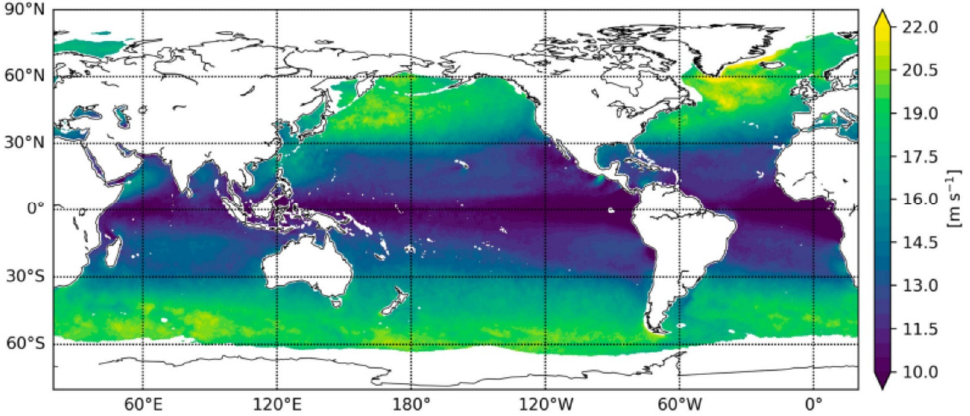
Figure 4. Ocean currents and research points. The red arrows represent warm currents, and the blue arrows represent cold currents. The ocean currents layer was compiled from the NOAA National Weather Service and the US Army and shared as an ESRI product. This data is free for personal and educational use only. Source: (a). https://www.arcgis.com/home/item.html?id=24bfd85e97b042948e6ed4928dc45a8b (accessed on 8 November 2022); (b). https://services1.arcgis.com/VAI453sU9tG9rSmh/ArcGIS/rest/services/WorldGeo_Physical_Climate_features/FeatureServer/8 (accessed on 8 November 2022).